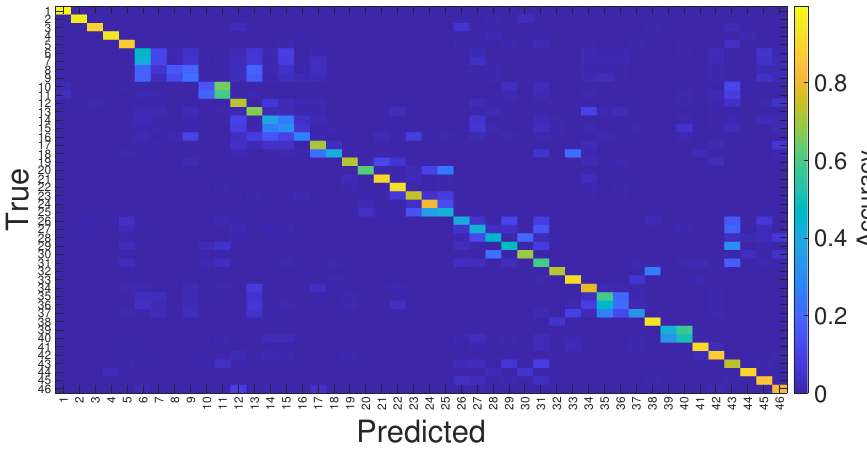
Figure 13. Confusion matrix with WHT and Opt seg = 32 at SNR = 10 dB.